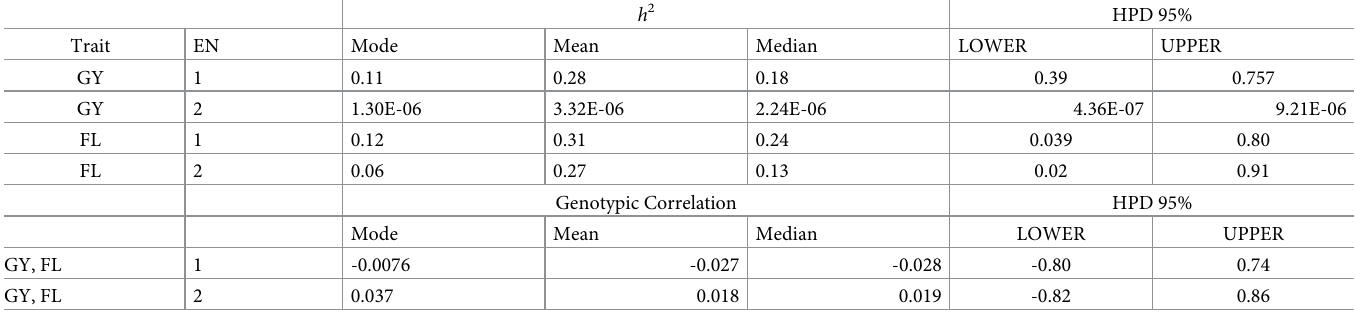
Table 3. Resume of inferences for mean and genetic variance; mode, mean, median, and highest posterior density range (HPD) of heritability in the broad sense; and the mode, mean, median, and highest posterior density range (HPD) of the genetic correlation, considering the complete model multi-trait and multi-